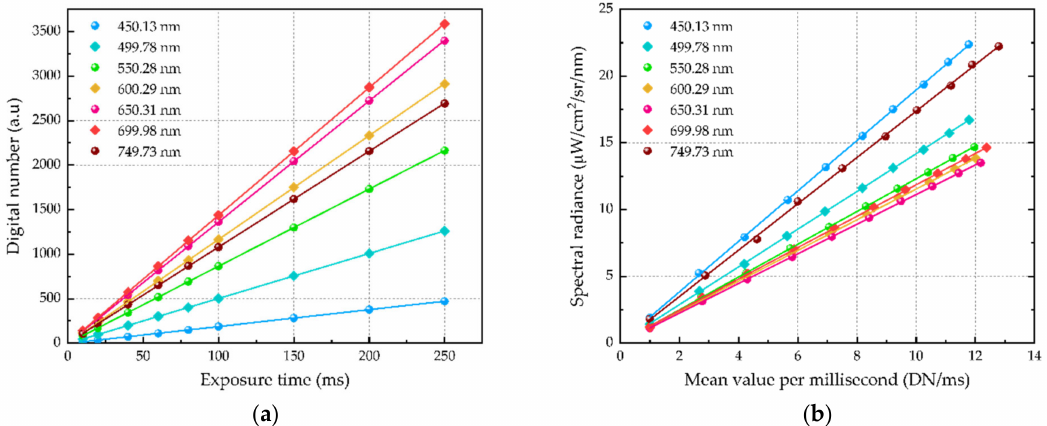
Figure 6. The results of the radiometric calibration: ( a ) the pixel intensity at different exposure times; ( b ) the mean value per millisecond versus the absolute spectral radiance in different spectral